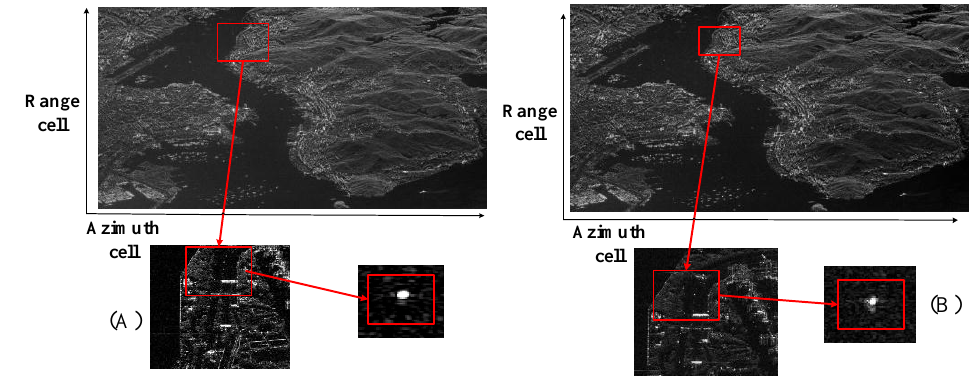
Figure 2. C-band VV-polarized image of Hong Kong obtained by the GF-3 system in sliding spotlight mode in 2016. ( A ) Using a weighting operation, and ( B ) without a weighting operation. Azimuth resolution is about 1 m. The extension of the area is of about 8 km × 10 km.